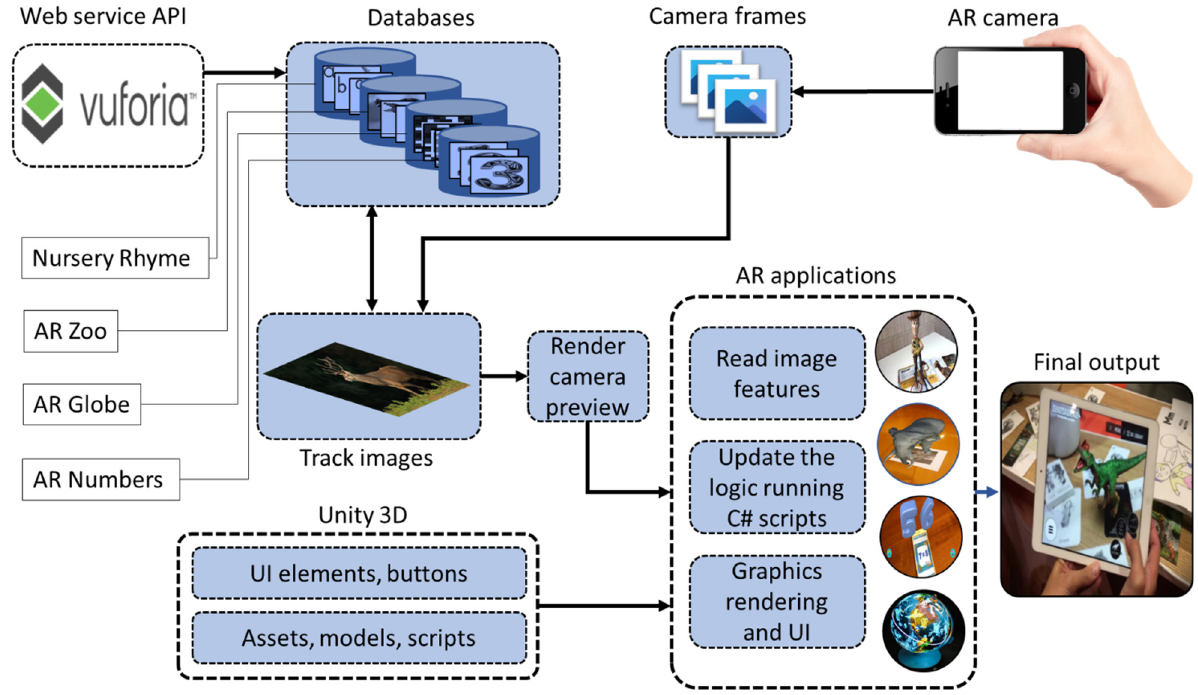
Figure 4. Working on AR-based mobile applications. Predefined target images are scanned with the AR camera using a smartphone. Upon target recognition, 3D visuals are augmented on the camera screen.